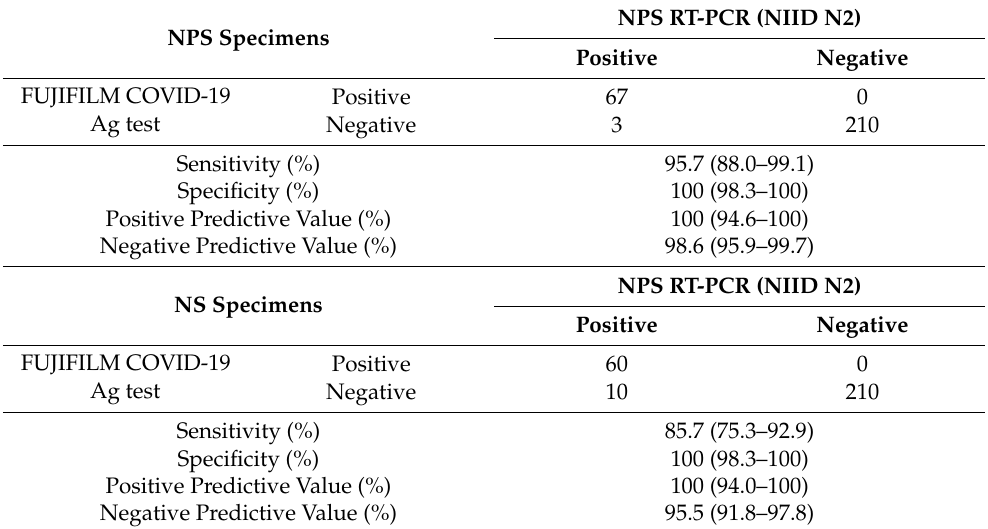
Table 3. Results of the FUJIFILM COVID-19 Ag test on nasopharyngeal swab (NPS) and nasal swab (NS) specimens.